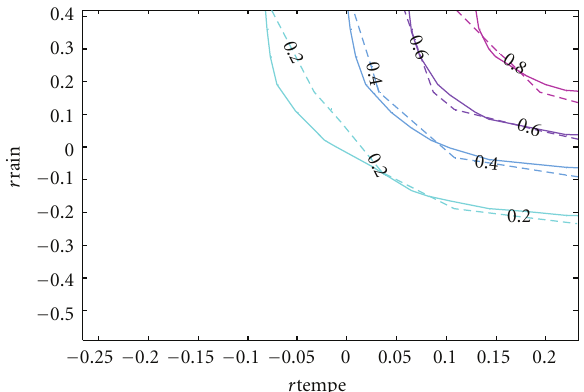
Figure 11: Real versus Clayton fitted CDF. Note: The dashed lines are the real CDFs while the solid lines are the simulated CDFs.